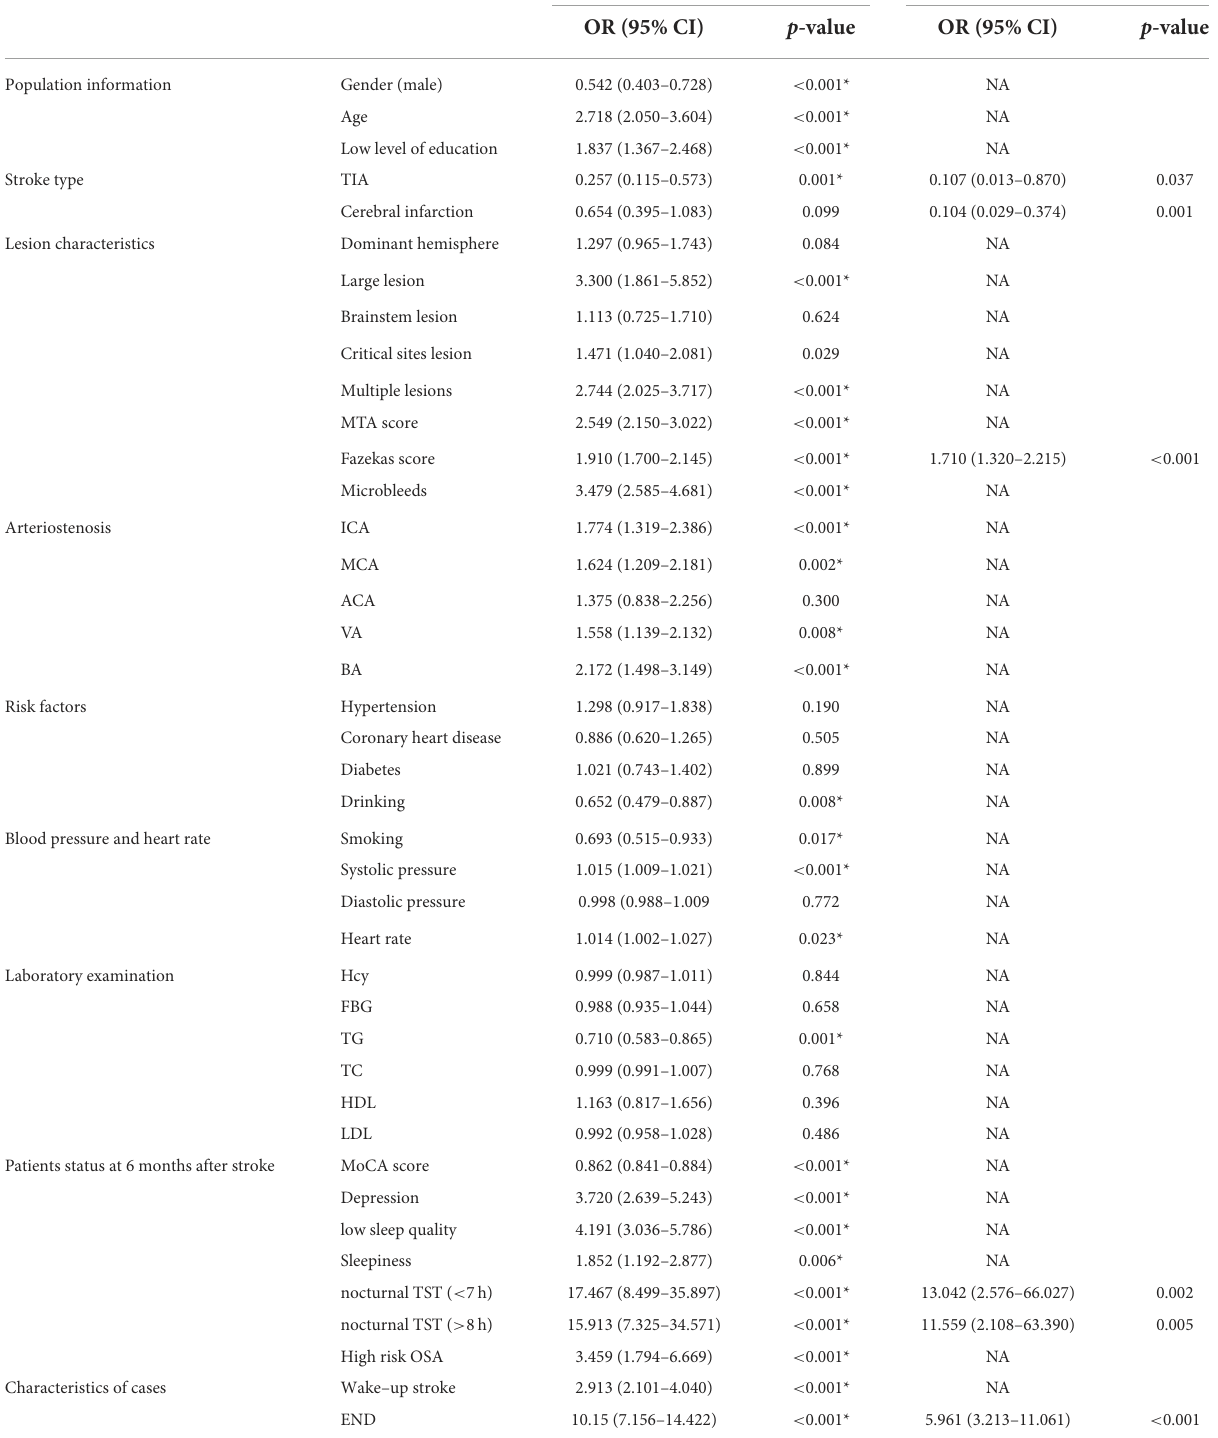
TABLE 3 Univariate and multivariate logistic analysis of neurological function at six months after